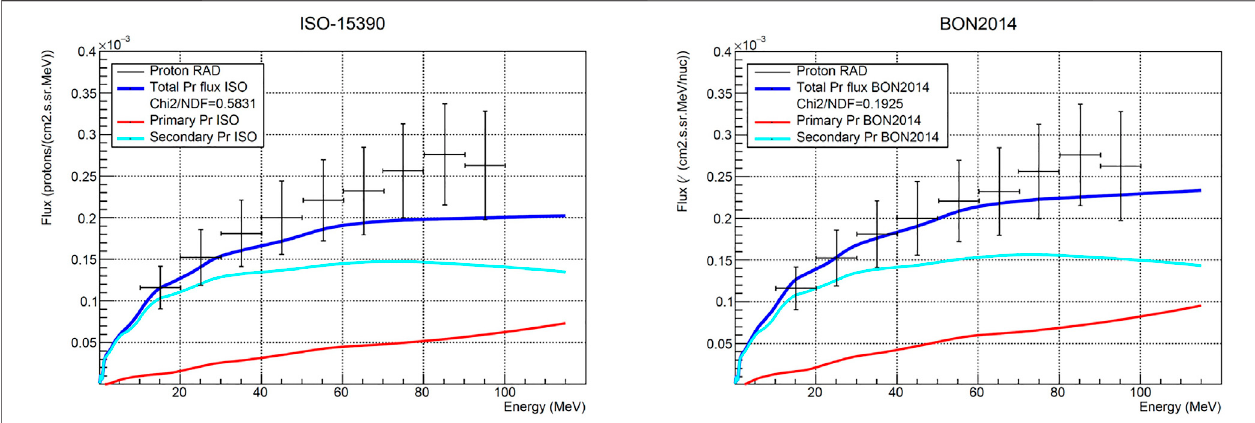
FIGURE 5 | Differential proton fl ux spectra obtained with dMEREM compared to GCR-induced proton spectrum measured by RAD in November 2015-January 2016, extracted from (Ehresmann et al., 2017). Protons from primary (red) and secondary (cyan) origin are shown. dMEREM prediction based on ISO-15390 fl ux prediction is shown on the left, while the prediction based on BON2014 model is shown on the right.